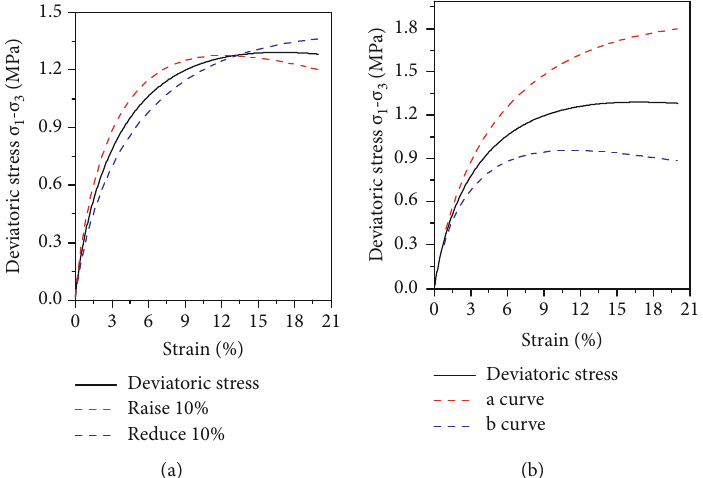
Figure 11: Comparison of the in fl uence of a 10% increase or decrease in multiple parameters of the model on the calculation curve (frozen silty